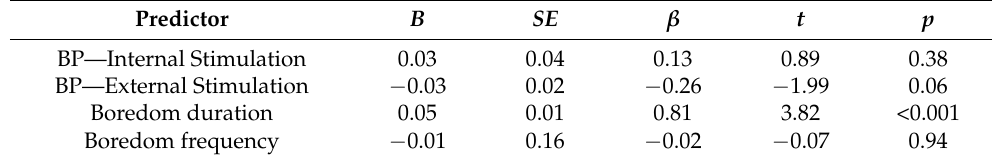
Table 4. Regression analysis of the association between boredom intensity and other boredom experiences.